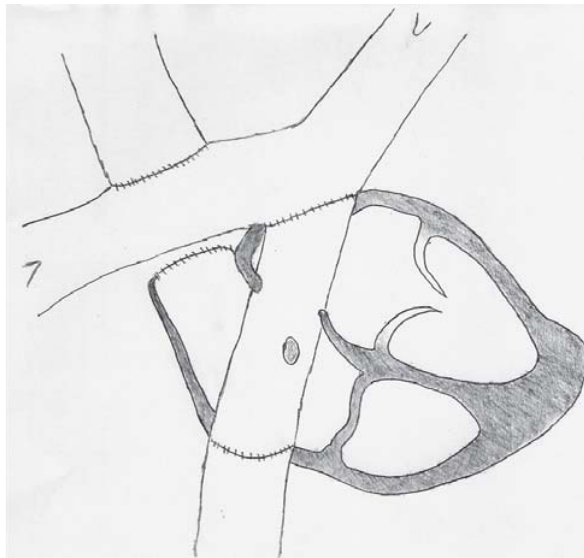
Fig. 1 - Operação de Fontan modificada. Observar o trajeto retilíneo entre a veia cava inferior, o conduto e o ramo esquerdo de artéria pulmonar. A presença de material rígido é minimizada, pois o caminho é mais curto Variáveis